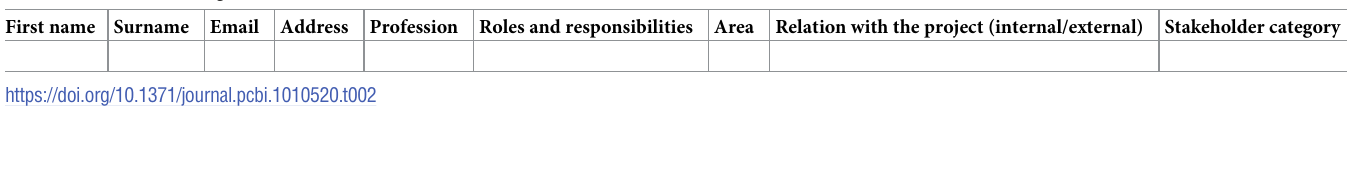
Table 2. Stakeholder